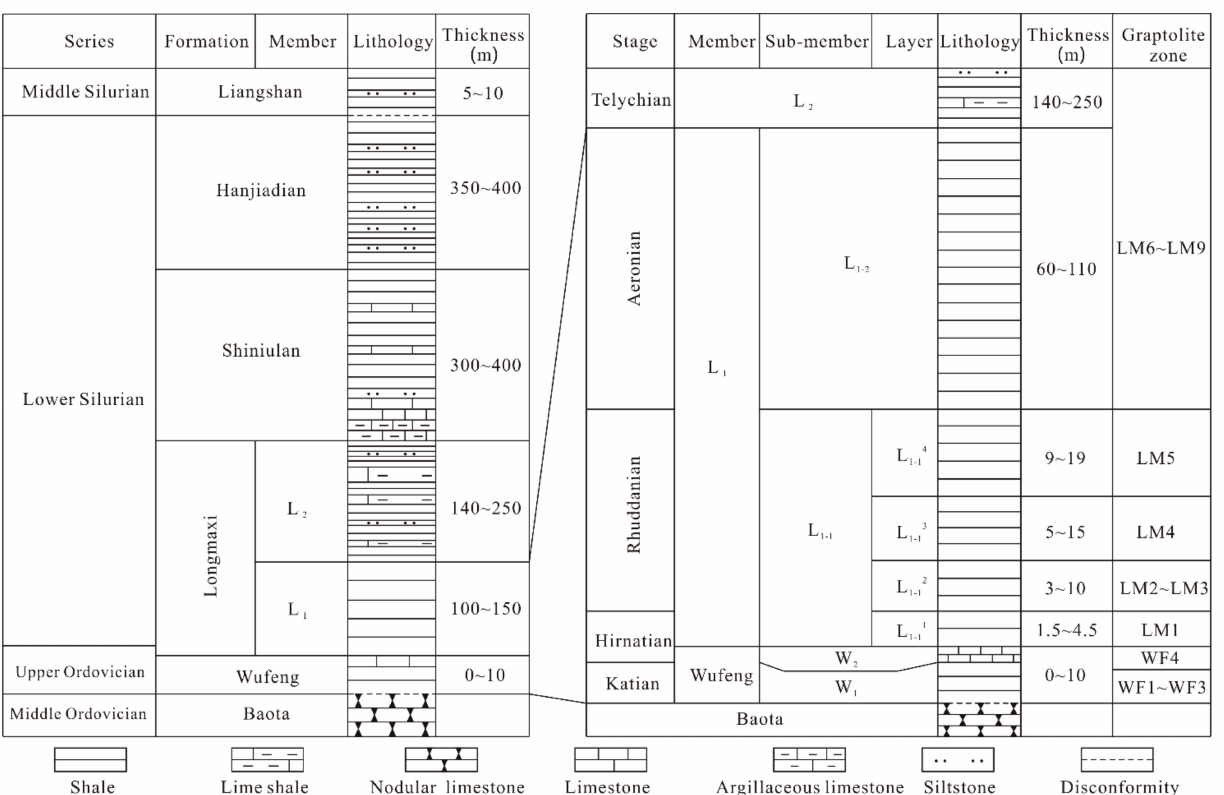
Figure 2. Chart showing the chrono- and litho-stratigraphy, lithology, and shale occurrences in the Wufeng–Longmaxi shale in the Sichuan Basin of southwestern China (compiled from